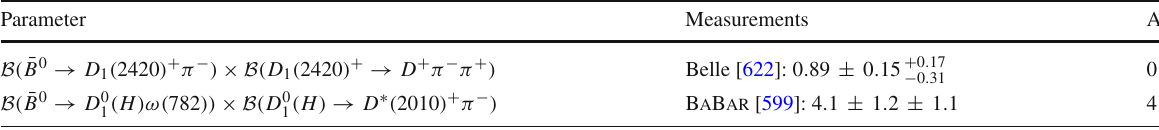
Table 101 Absolute product decay rates to excited D mesons I [ 10 − 4 ]